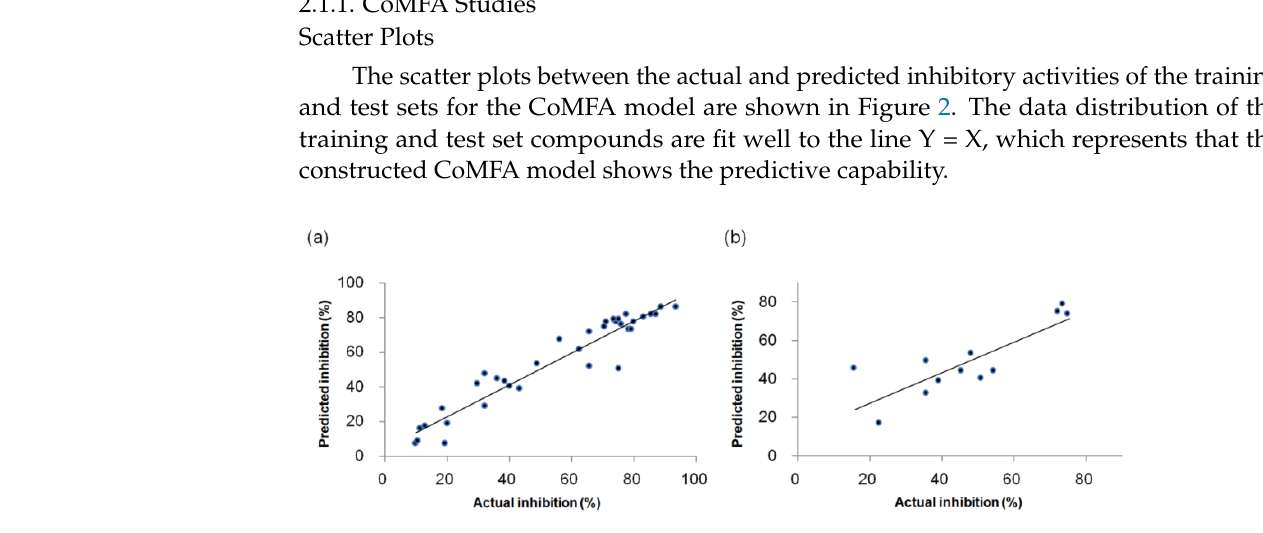
Figure 2. Scatter plots of the actual versus predicted inhibitory activities for the CoMFA model; ( a ) The training set; ( b ) The test